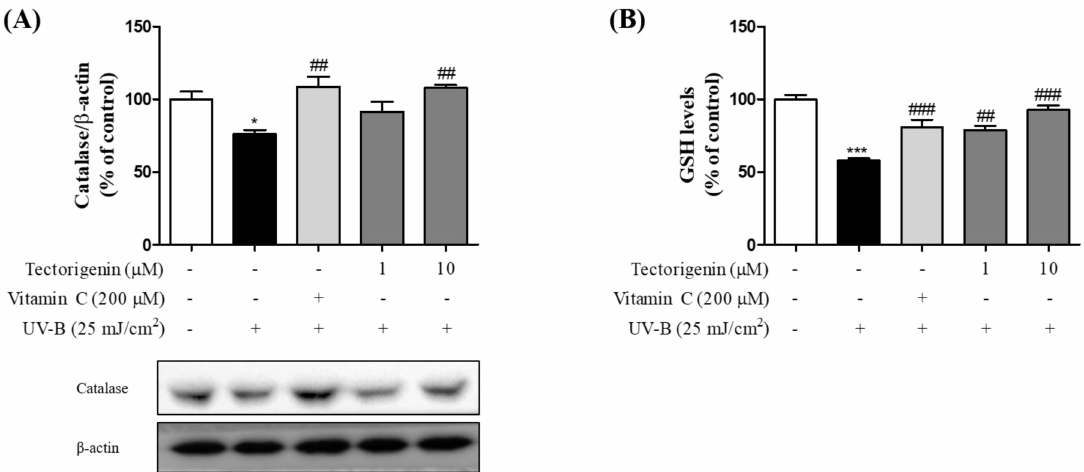
Figure 4. Inhibitory effects of tectorigenin on UV-B-induced downregulation of anti-oxidative enzymes in HaCaT cells. The cells were irradiated with 25 mJ/cm 2 UV-B and treated with tectorigenin at 1 and 10 µ M or vitamin C at 200 µ M for 24 h ( A , B ). Levels anti-oxidative enzymes were measured by a Western blot analysis. Values are given as the mean ± SEM. * p < 0.05, *** p < 0.001 versus control group, ## p < 0.01, ### p < 0.001 versus UV-B-only treated group.